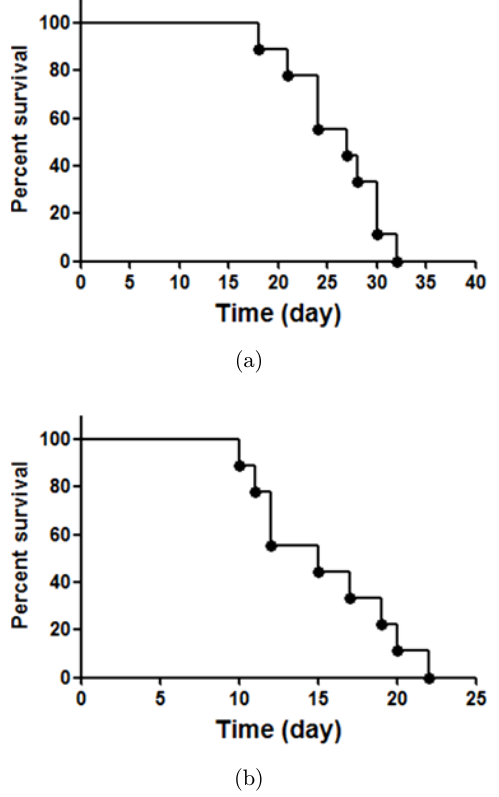
Fig. 8. The survival rate of two types of tumor models was signi¯cant di®erence. The median survival time is 27.5 d in s.c. tumor models (a), and 15 d in orthotopic tumor models (b). p < 0 : 0001, n ¼ 10 in each group.